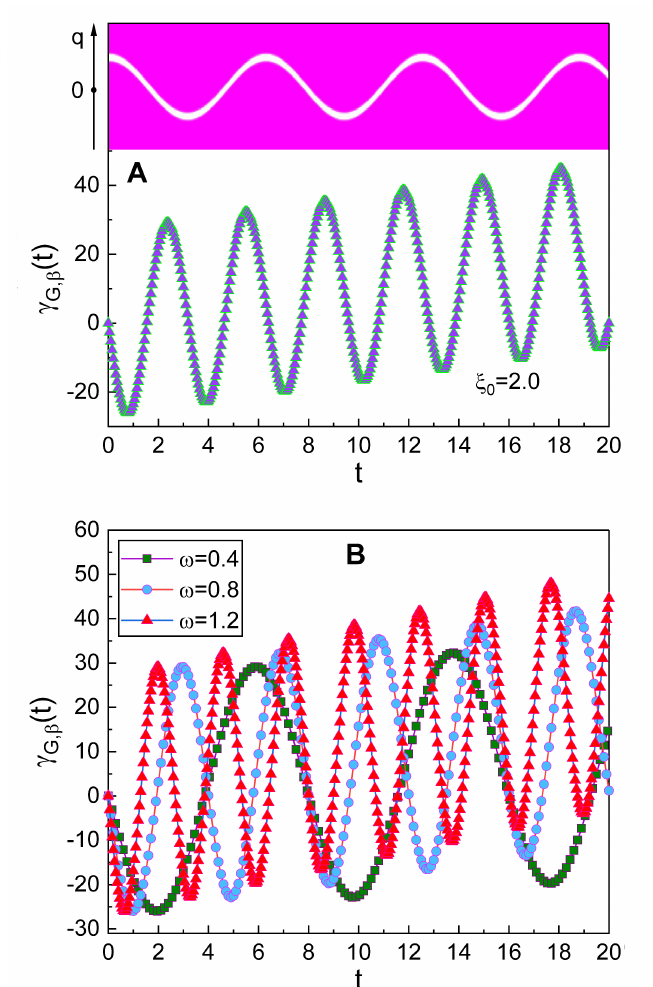
Figure 3. Comparison of the period of the geometric-phase oscillation with other fundamental periods related to the wave. ( A ): The geometric-phase oscillation (lower part) and the oscillation of the corresponding probability density |(cid:104) q | β (cid:105)| 2 (upper part) in q space. We have used ξ 0 = 2.0, (cid:101) = 1, and ¯ h = 1, while the values of all other data used in the plot are the same as those in Figure 2A. ( B ): Temporal evolution of the geometric phase in the squeezed state for several values of ω . We have used α 0 = 1, ξ 0 = 2, λ = 0, ϕ = θ = 0, and γ 0 =